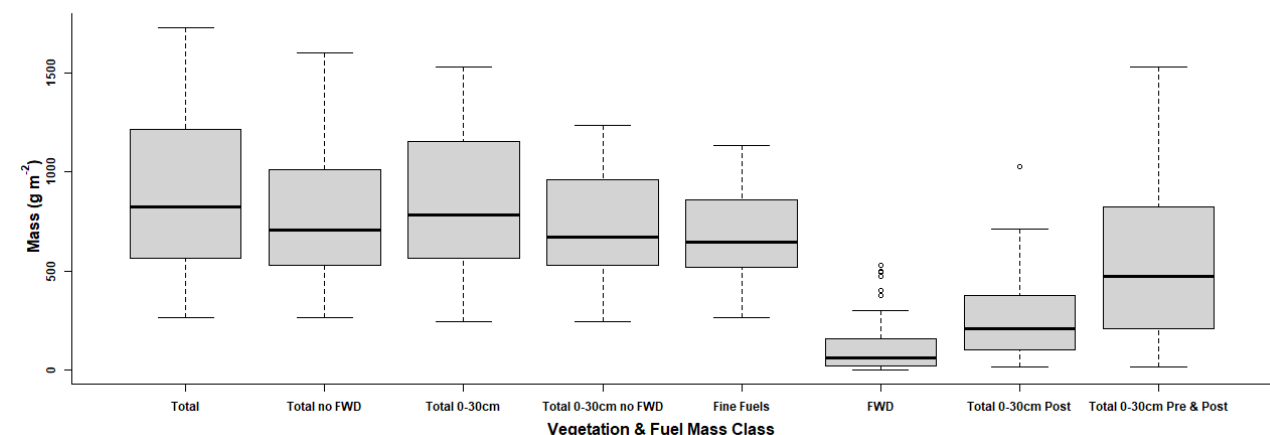
Figure 2. Box plots of surface dry mass (g m − 2 ) distinguished by our vegetation and fuel mass classes. All box plots include only pre-burn biomass data ( n = 41), except for Total ‘0–30 cm Post’, which includes only post-burn data ( n = 41) and ‘Total 0–30 cm Pre and Post’, which includes both pre- and post-burn data ( n = 82). See text and Appendix A for fuel class and category descriptions.